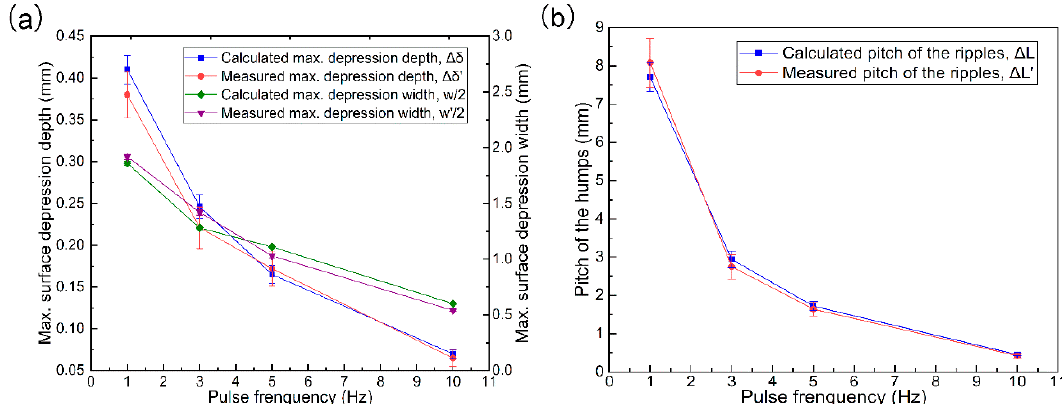
Figure 13. Calculated profiles of the weld pool depression with different pulse frequency: ( a ) weld pool depression, and ( b ) pitch of the humps.